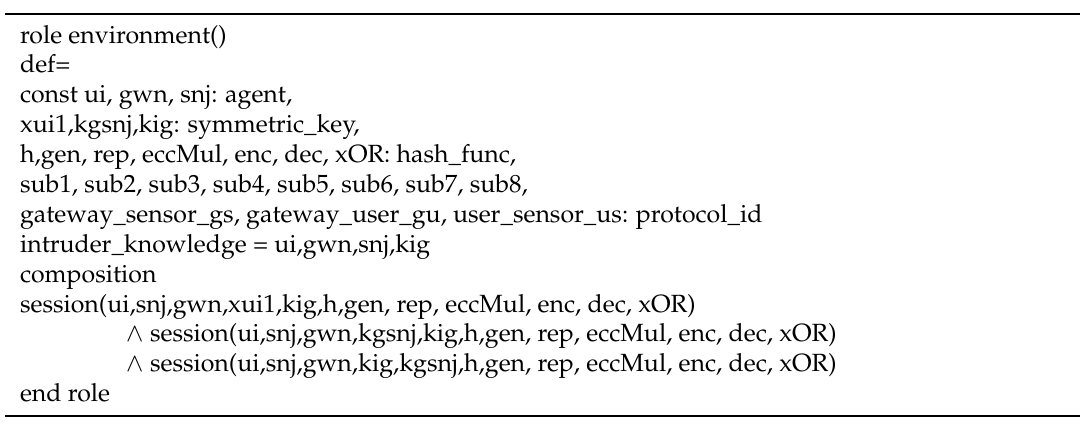
Table 18. Specification of proposed protocol’s environment in